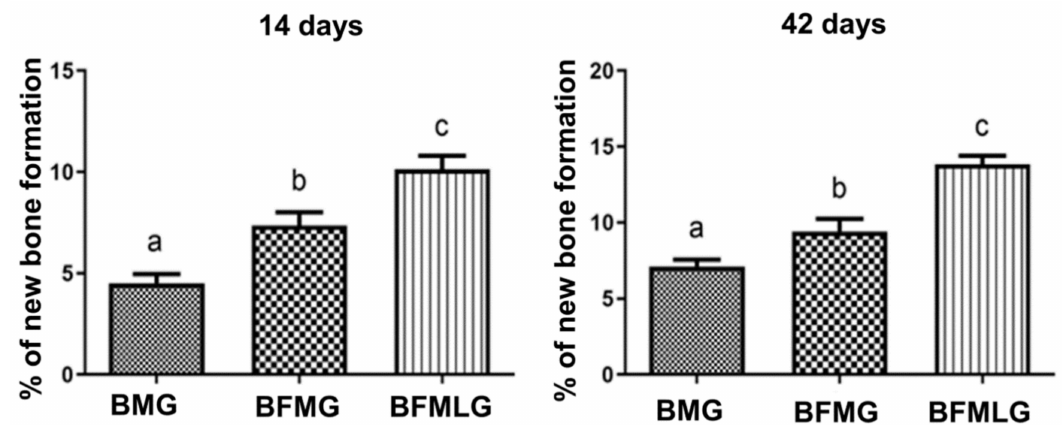
Figure 5. Percentage of new bone formation in each group (BMG, BFMG, and BFMLG) in the two experimental periods (14 or 42 days). Different lowercase letters indicate a significant difference. Values defined as the mean ± standard deviation ( p < 0.05), ANOVA test for independent samples and the “post hoc” Tukey’s test ( p <